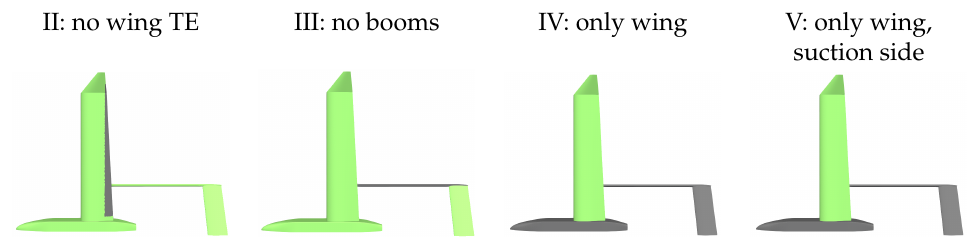
Figure 16. Schematic drawing of various riblets coverage configurations, cases